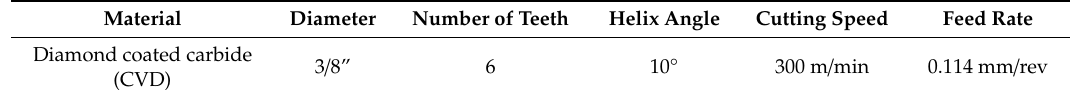
Table 1. Tool and cutting parameters.